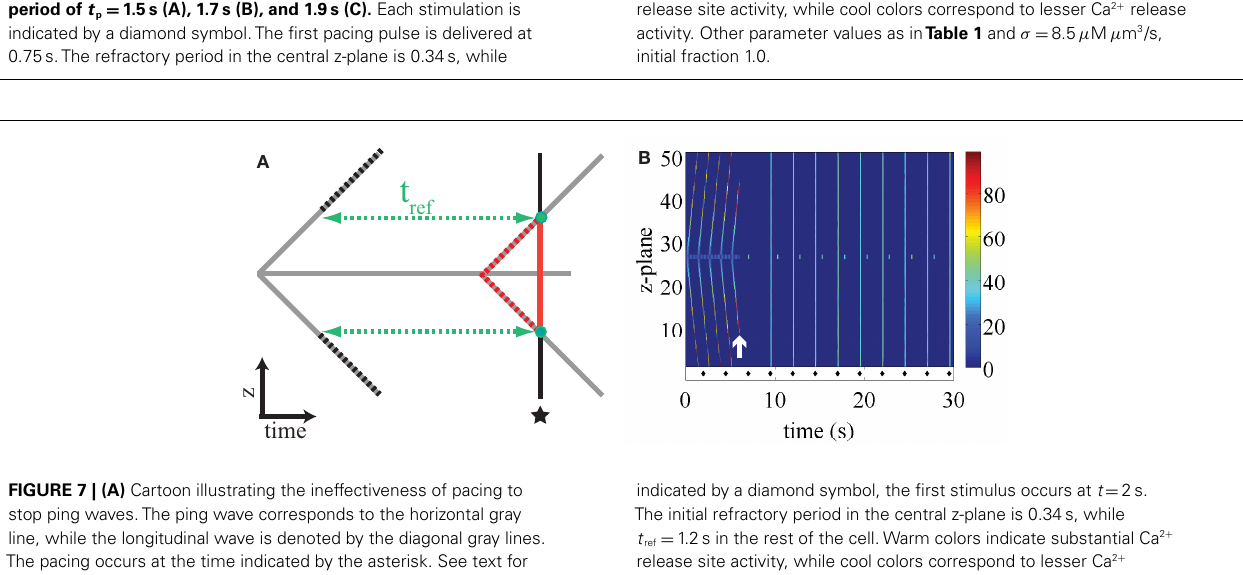
t ref = 1.3s in the rest of the cell.Warm colors indicate substantial Ca 2 + release site activity, while cool colors correspond to lesser Ca 2 + release